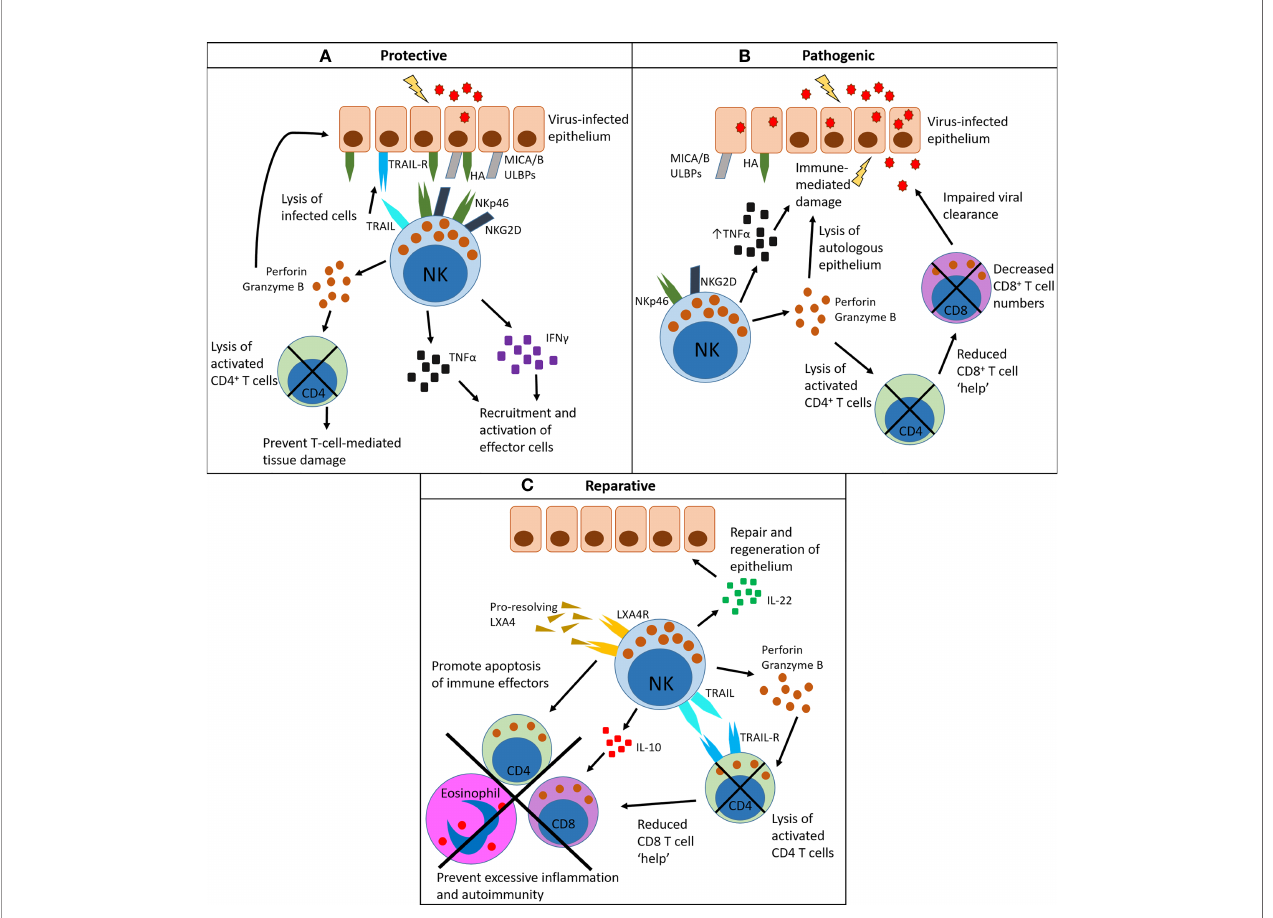
FIGURE 2 | Pleiotropic functions of NK cells in the lung: protective, pathogenic and reparative. (A) NK cells have a protective role by recognizing virally infected cells that display viral proteins on their surface (for example, HA) and/or upregulate damage-associated molecules (for example, MICA/B and ULBPs). These bind to activating receptors on NK cells such as NKp46 (which binds HA) and NKG2D (which binds MICA/B and ULBPs). Once activated in this way, NK cells produce the in fl ammatory cytokines TNF a and IFN g , which aid recruitment of effector cells to the site of infection and facilitate their activation. They also produce perforin and granzyme B, which directly lyse infected cells, and can mediate the contraction of activated CD4 + T cells to prevent immune-mediated tissue damage. Lysis of infected cells can also be death-receptor-mediated, via TRAIL or FasL. (B) NK cells can drive a pathogenic outcome in infection, particularly in cases of high viral load. Here activated NK cells produce excessive amounts of TNF a , which damages the epithelium and causes excessive recruitment of other immune cells. Excess lysis of activated CD4 + T cells through the release of perforin and granzyme removes the help for other immune cell subsets, particularly virus-speci fi c CD8 + T cells, which results in impaired viral clearance. (C) NK cells can mediate the resolution of in fl ammation following infection. They are a source of IL-22, which promotes repair of the epithelium. They express the receptor LXA4R, which binds to the pro-resolving mediator LXA4. As a result of LXA4 binding, NK cells promote the apoptosis of immune effector cells such as CD8 + T cells and eosinophils. They also clear activated CD4 + T cells in a TRAIL-dependent manner, reducing CD8 + T cell help. NK cells also produce IL-10 which has general anti-in fl ammatory activity. Together, these clearance mechanisms prevent prolonged in fl ammation after